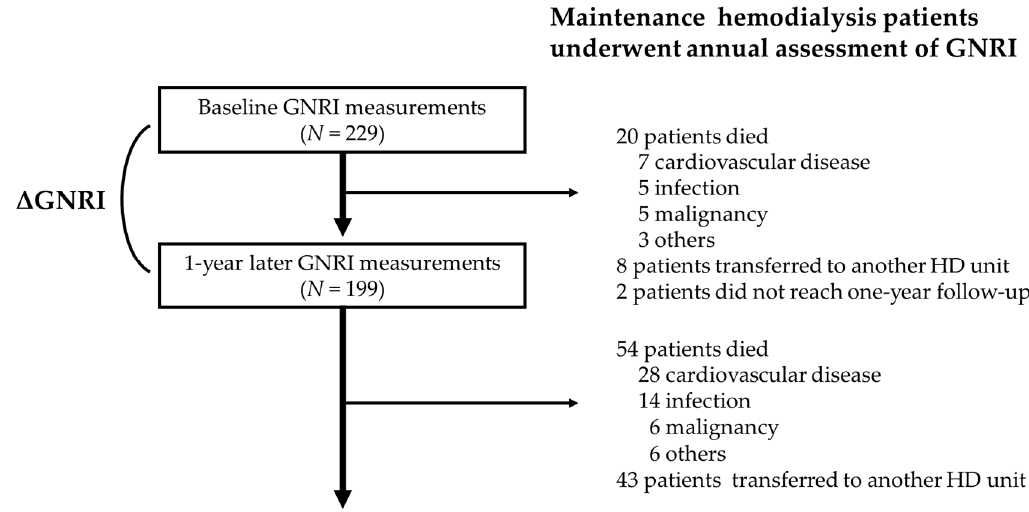
Figure 1. Flow diagram of the present study. GNRI, geriatric nutritional risk index; ∆ GNRI, annual change in GNRI; HD, hemodialysis.